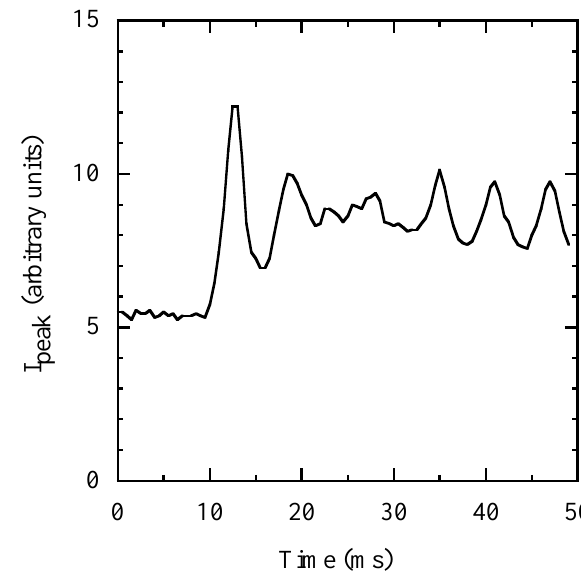
FIG. 7. Peak current as a function of time in the acceleration cycle. Bunching starts at 8